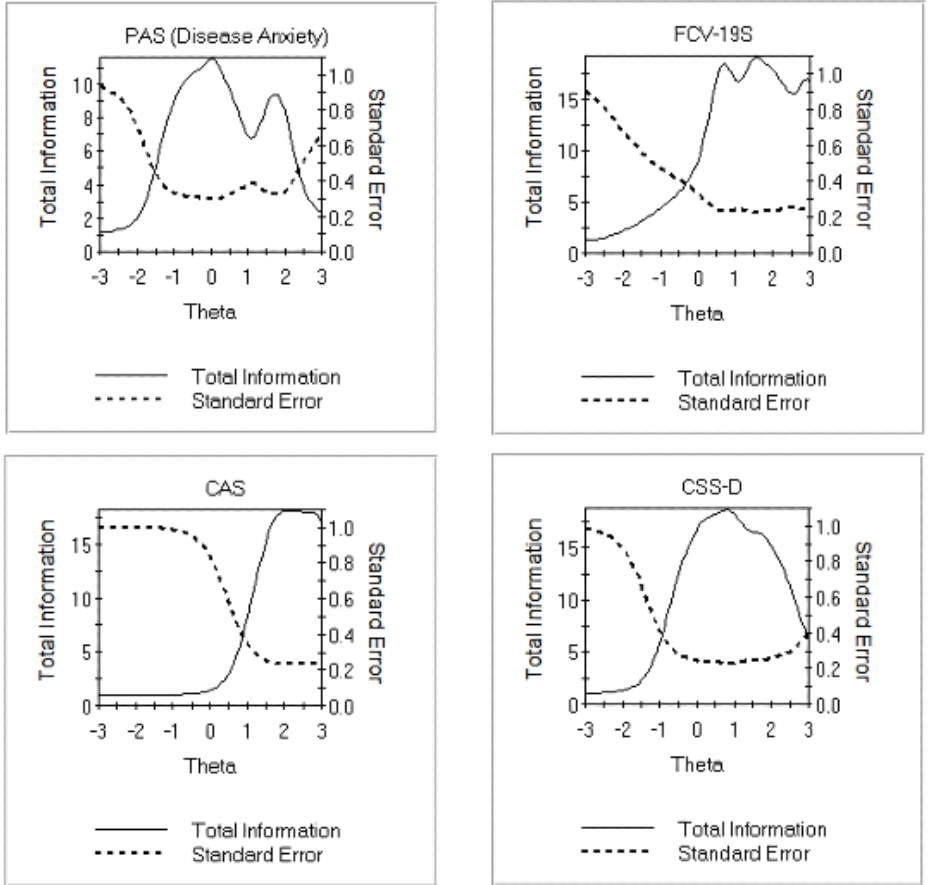
Figure 1. Total information functions for the PAS, FCV-19S, CAS and CSS-D scales. CAS: Coronavirus Anxiety Scale; CSS-D: COVID Stress Scales–Danger subscale; FCV-19S: Fear of COVID-19 Scale; PAS: Pandemic Anxiety Scale.